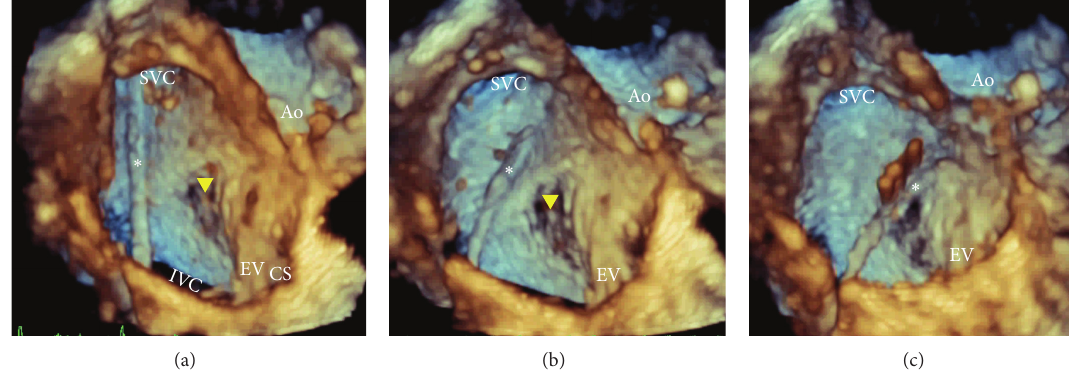
Figure 3: RT3DTEE anatomically oriented view of the IAS from the RA perspective during guidance of transseptal puncture. The puncture catheter (asterisk) was introduced through the IVC into the SVC (a). Then the catheter (asterisk) was pulled inferiorly and anteriorly towards the thin part of the IAS (arrow head) “Fossa” (b and